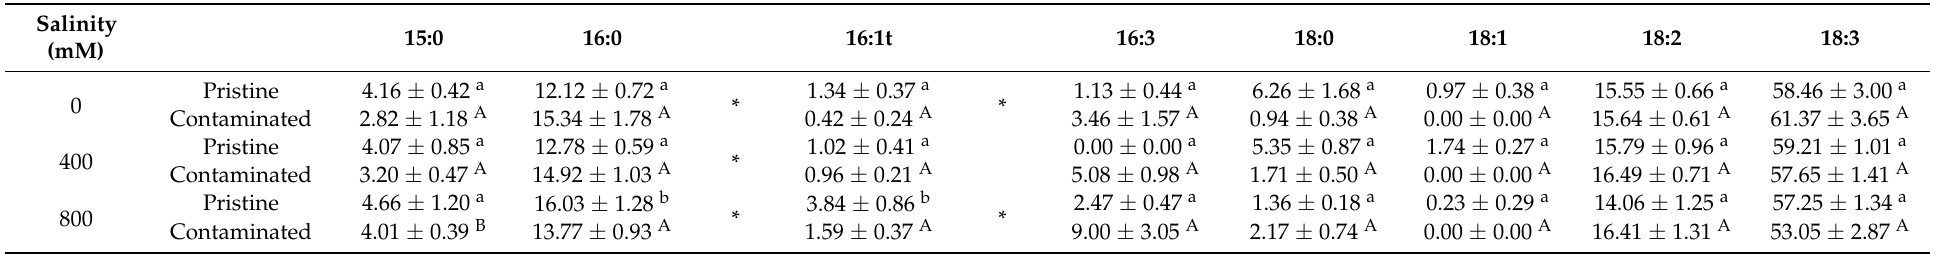
Table 1. Fatty acid relative content (%, average ± standard error, N = 5) namely, pentadecanoic acid (C15:0), palmitic acid (C16:0), trans-delta 3-hexadecenoic acid (C16:1t), hexadecatrienoic acid (C16:3), stearic acid (C18:0), oleic acid (C18:1), linoleic acid (C18:2) and linolenic acid (C18:3) in S. patens leaves from pristine and heavy metal contaminated sites, along with the tested NaCl concentrations. Letters indicate significant differences between treatments at p < 0.05; asterisks mark significant differences between populations at p < 0.05.